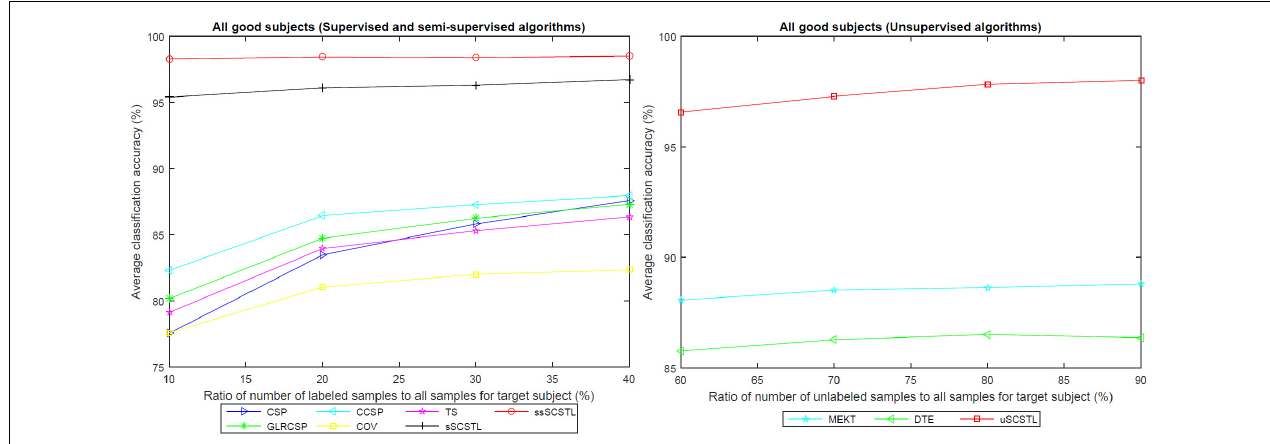
FIGURE 4 | The means of accuracies of all good subjects on dataset MI1 for different algorithms with varying R l or R u .